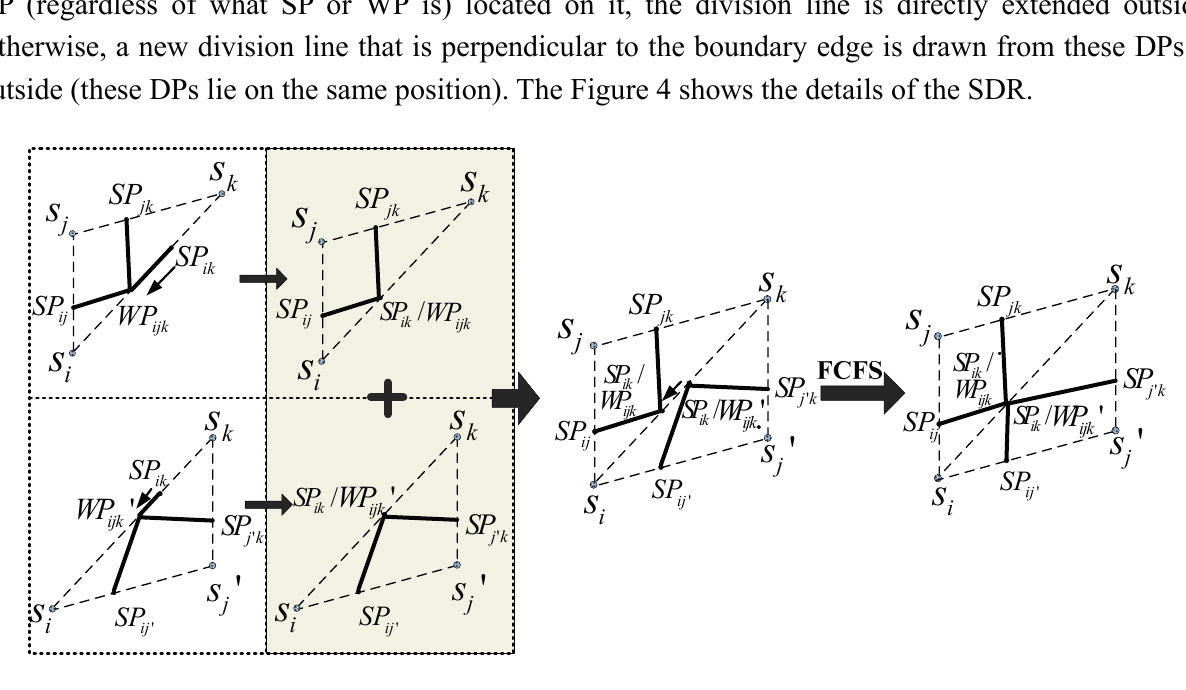
Figure 3. Cases based on CRR where the positions of DPs that share the same edge are